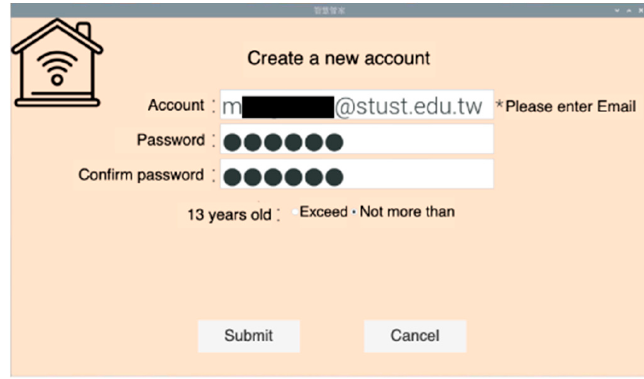
Figure 9. Interface of account creation under 13 years old.